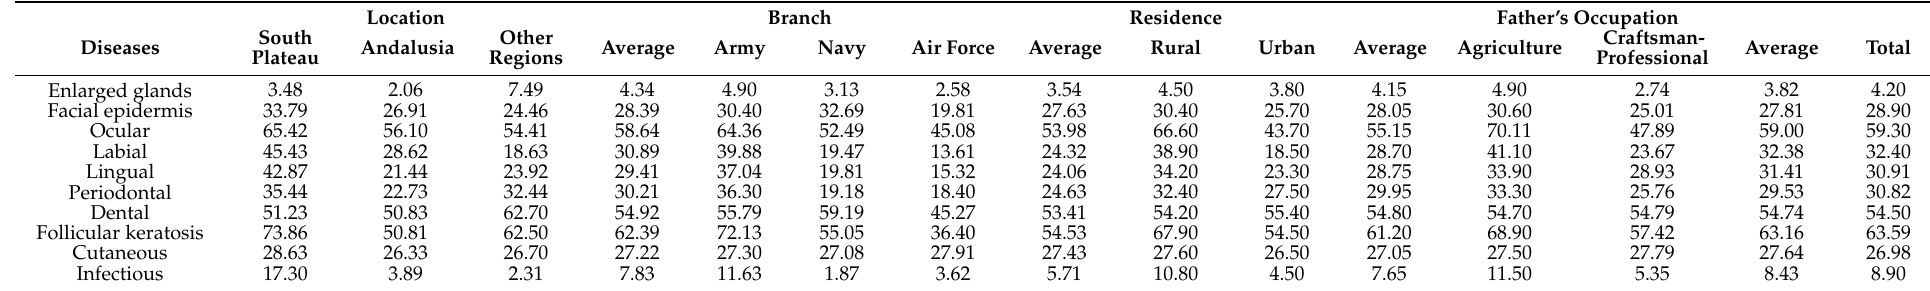
Table A2. Detailed medical check: incidence of diagnosed diseases by location, armed forces branch, residence and occupation (per 100 subjects).